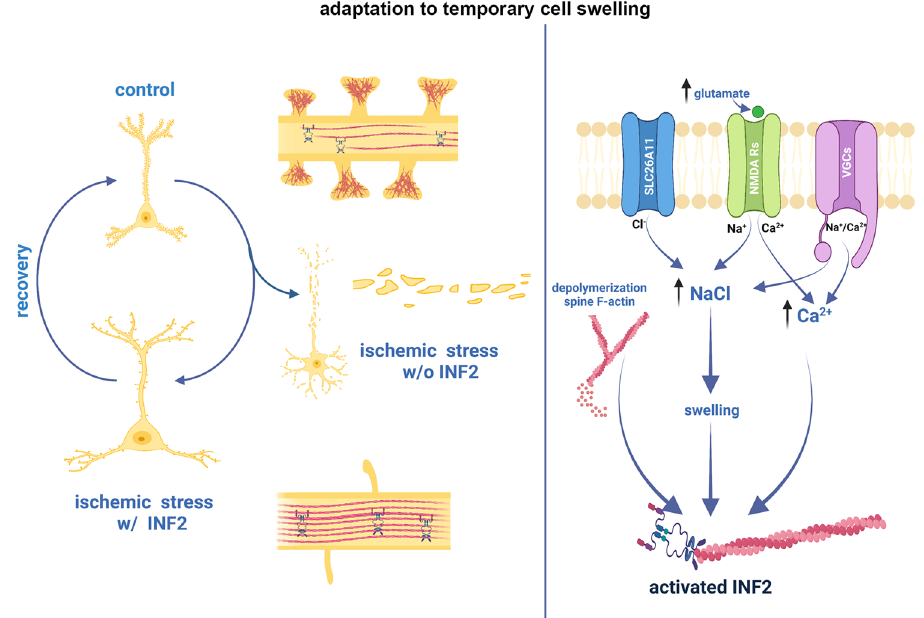
Fig. 8 | Model for the mechanism and function of ischemia-induced neuronal actini fi cation. (Left) In response to ischemic stress, neurons undergo osmotic swellingandanextensive,butreversible,INF2-mediatedreorganizationoftheactin cytoskeleton, characterized by F-actin disassembly in dendritic spines and F-actin accumulation in the dendrite shaft (actini fi cation).In the absenceof INF2,neurons